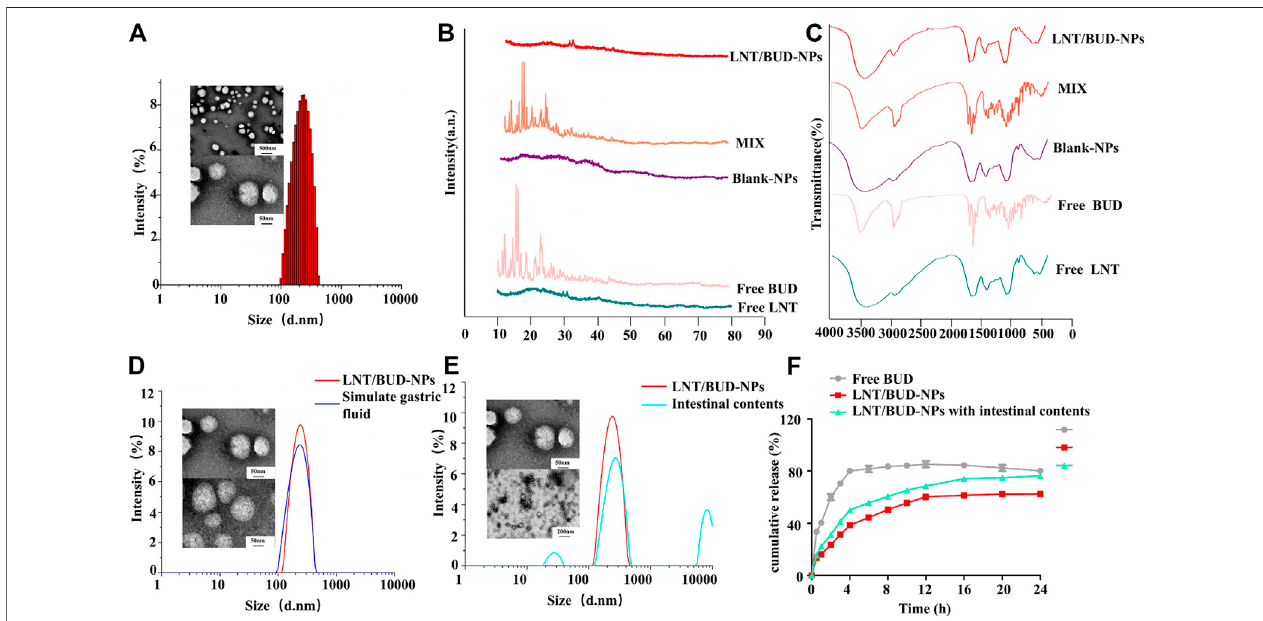
FIGURE 1 | Characterization stability evaluation of NPs. (A) Size distribution and TEM images of LNT/BUD-NPs. (B) XRD spectrum of different formulas. (C) IR spectrum of different formulas. (D) Size distribution and TEM images of LNT/BUD-NPs in PBS or simulated gastric fl uid. (E) Size distribution and TEM images of LNT/ BUD-NPs in PBS or mice intestinal contents. (F) Release pro fi le of Free BUD, LNT/BUD-NPs in PBS, and LNT/BUD-NPs in mouse intestinal contents.